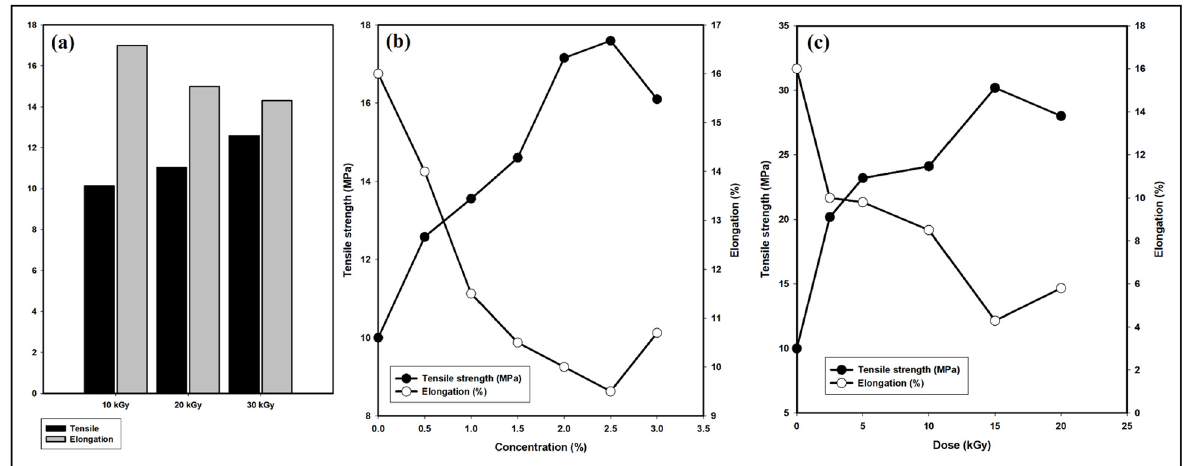
Figure 6: E ff ect of TiO 2 particle size ( a ) , TiO 2 contents ( b ) , and irradiation dose ( c ) on mechanical properties of CMC/starch/TiO 2